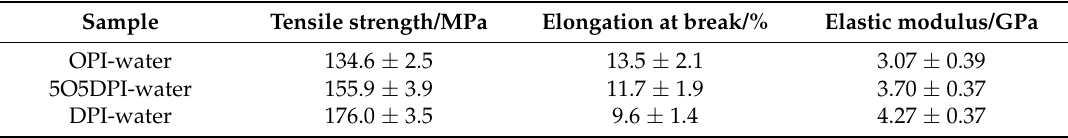
Table 4. Mechanical properties of the polyimide films after saturated with water.